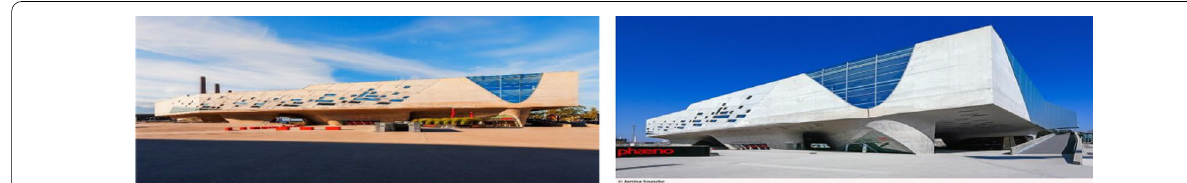
Fig. 10 Project of Phaeno Science Centre Wolfsburg